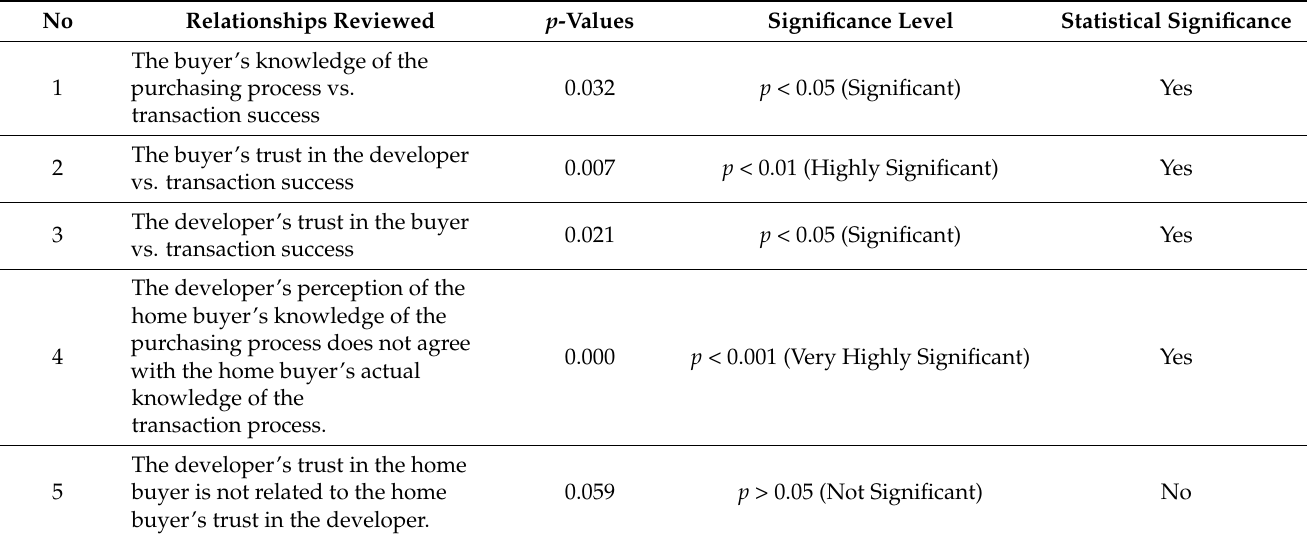
Table 6. Mann–Whitney U test